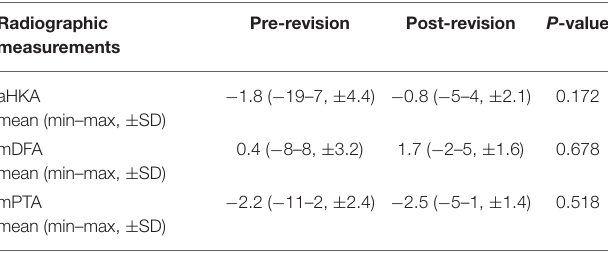
TABLE 6 | Radiographic measurements (negative value represents varus and positive represents